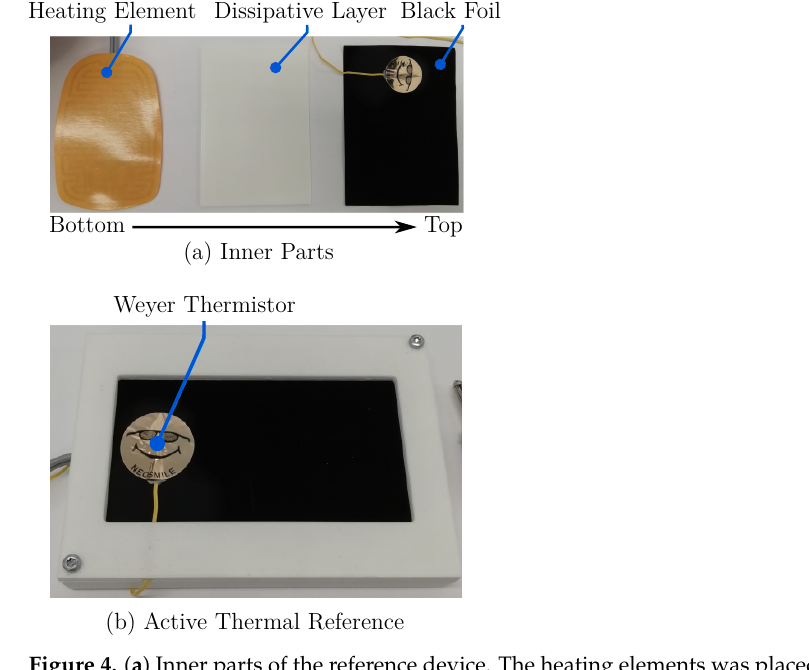
Figure 4. ( a ) Inner parts of the reference device. The heating elements was placed under a dissipative layer and an overlying black foil. ( b ) Assembled active thermal reference body with an attached Weyer